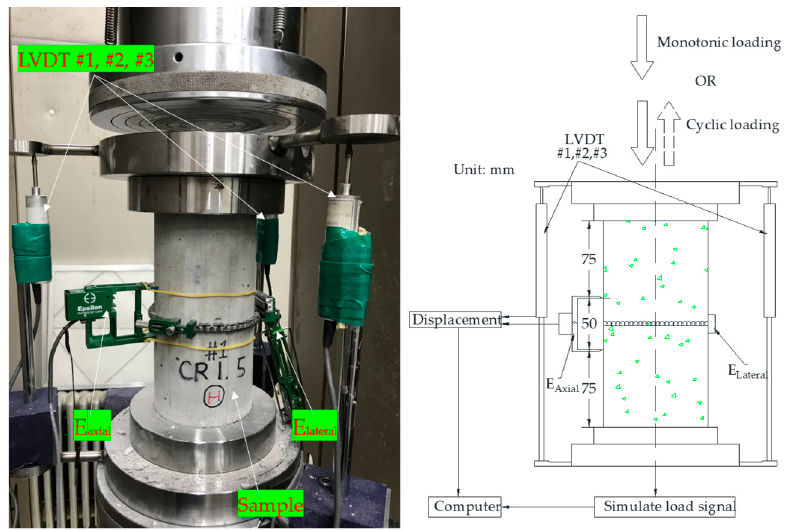
Figure 4. Test procedures. For monotonic compression, the constant load of 0.25 ± 0.05 MPa/s applied con- tinuously and without shaking until failure. For cyclic compression, the unloading and reloading processes repeated with the step of 0.4 mm displacement and the speed of 0.3 mm/min. The starting point of reloading process at each step was set-up at the com- pressive force of 5 kN. The cyclic loading in a compressive test is slightly different from that in the flexural test because the reloading processes are in the same direction [22]. The load scheme of cyclic compressive test is presented in Figure 5.